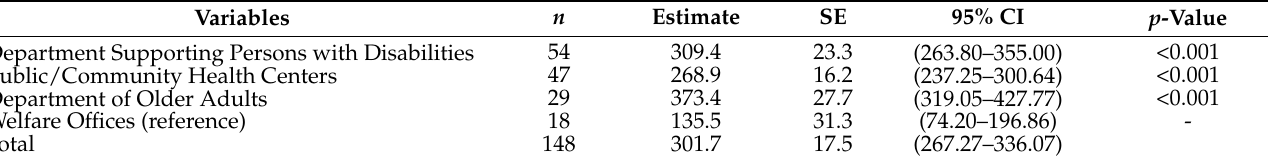
Table 3. The length of the care period needed in each department to resolve the primary health issue of the